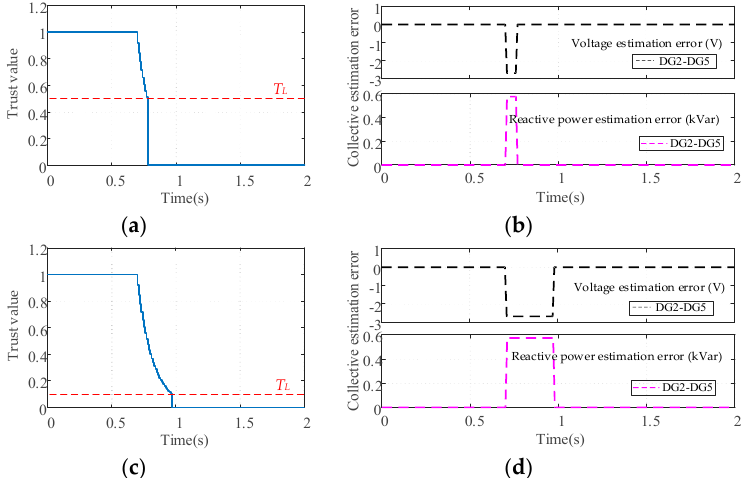
Figure 12. The impacts of isolation threshold T L on the collective estimation error: ( a ) DG1’s common trust value under T L = 0.5; ( b ) Collective estimation error of DG2 to DG5 under T L = 0.5; ( c ) DG1’s common trust value under T L = 0.1; ( d ) Collective estimation error of DG2 to DG5 under T L = 0.1.